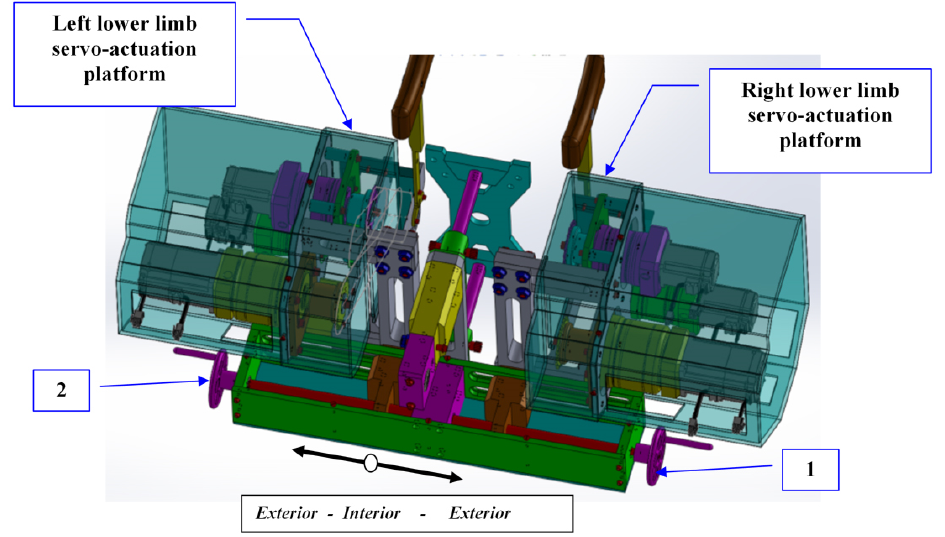
Figure 20. Detailed view of the exoskeleton actuation system.